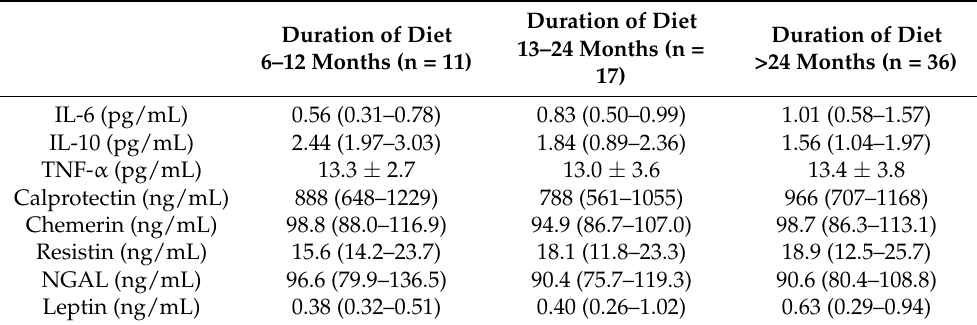
Table 5. Serum concentration of biomarkers associated with inflammation in subgroups of children with CMA according to the duration of